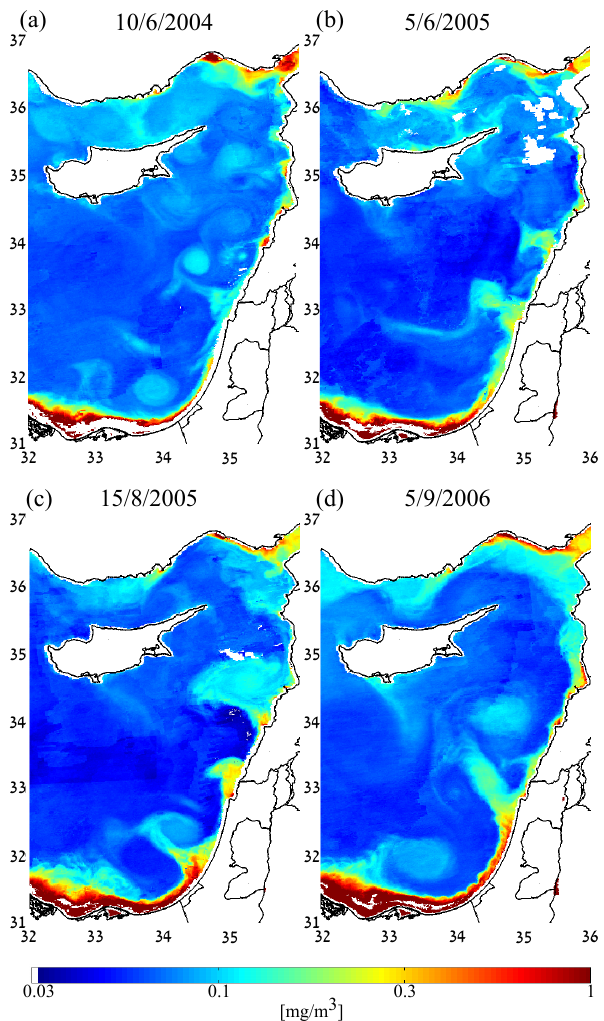
Fig. 1. Distribution patterns of surface chlorophyll a in the Levan- tine Basin of the eastern Mediterranean, emphasizing the abundance of mesoscale structure extending from the coastal area to the open sea at four different dates. To reduce the area masked by clouds, the images are composed of 8 consecutive days. Throughout the manuscript, surface chlorophyll a and temperature images are de- rived from MODIS-Aqua 1km data.